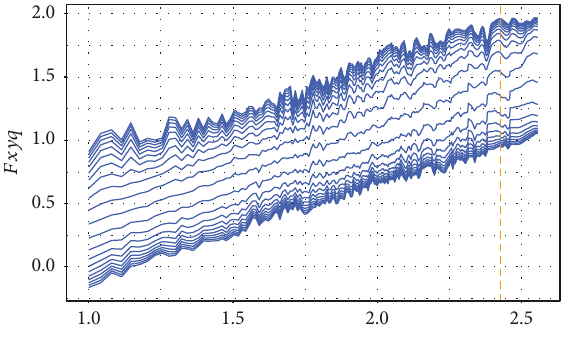
Figure 5: Log-log plots of 𝐹 𝑥𝑦𝑞 (𝑠) versus 𝑠 for amount of NM news and the return of SSE